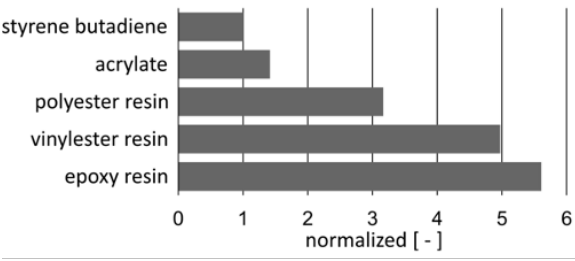
Figure 2. Comparison of the GWP of di ff erent matrix materials (normalized values).